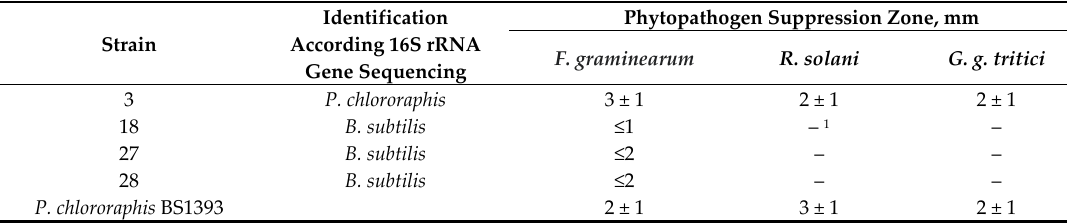
Table 1. Antagonistic activity of soil strains against phytopathogenic fungi